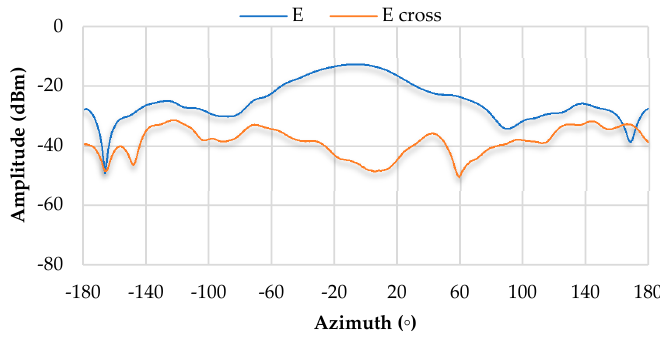
Figure 23. Representation of the radiation diagram for 0° in the E plane.